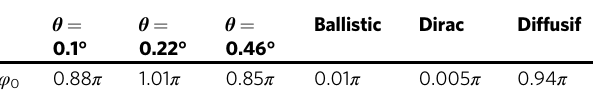
The three fi rst columns show the anomalous phase shifts extracted from the last nodes of the critical current oscillations shown in Fig. 5 for the three curves taken at different angles θ . The last three columns show the calculated anomalous phase shifts in the ballistic regime, for the Rashba-split conduction states and Dirac states, and in the diffusive regime, for the Rashba-split conduction states. These theoretical values are calculated using α = 0.4eVÅ for the Rashba- split conduction states and α = 3eVÅ for the Dirac states. See main text for the formula and other